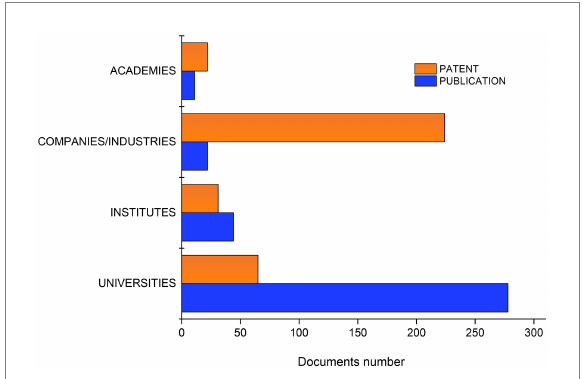
FIGURE 5 Number of patent filings and publications submitted by different